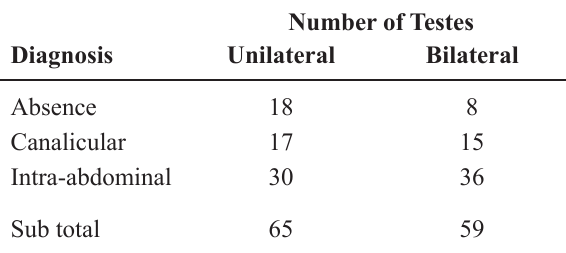
Table 3 – Laparoscopic